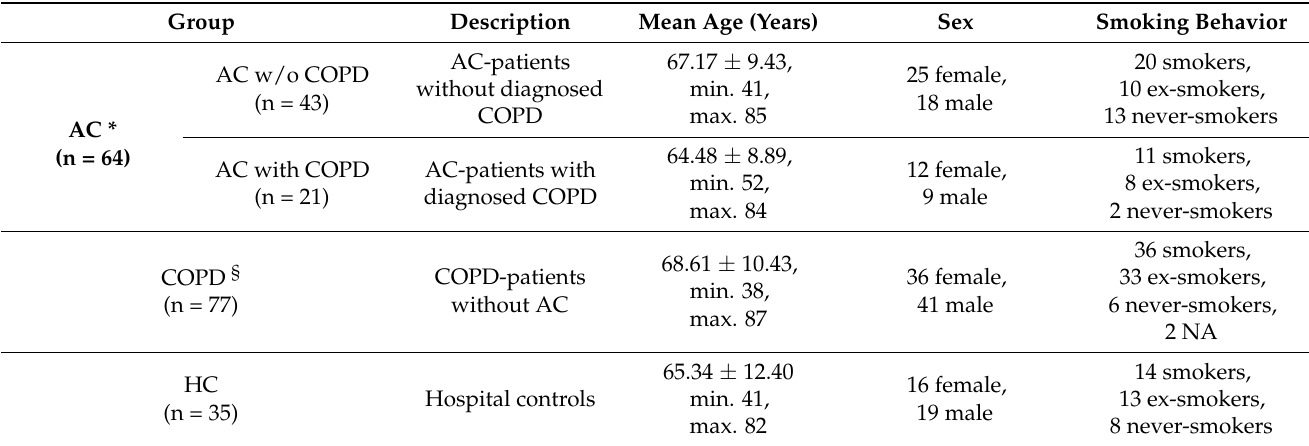
Table 4. Composition of the analyzed patient